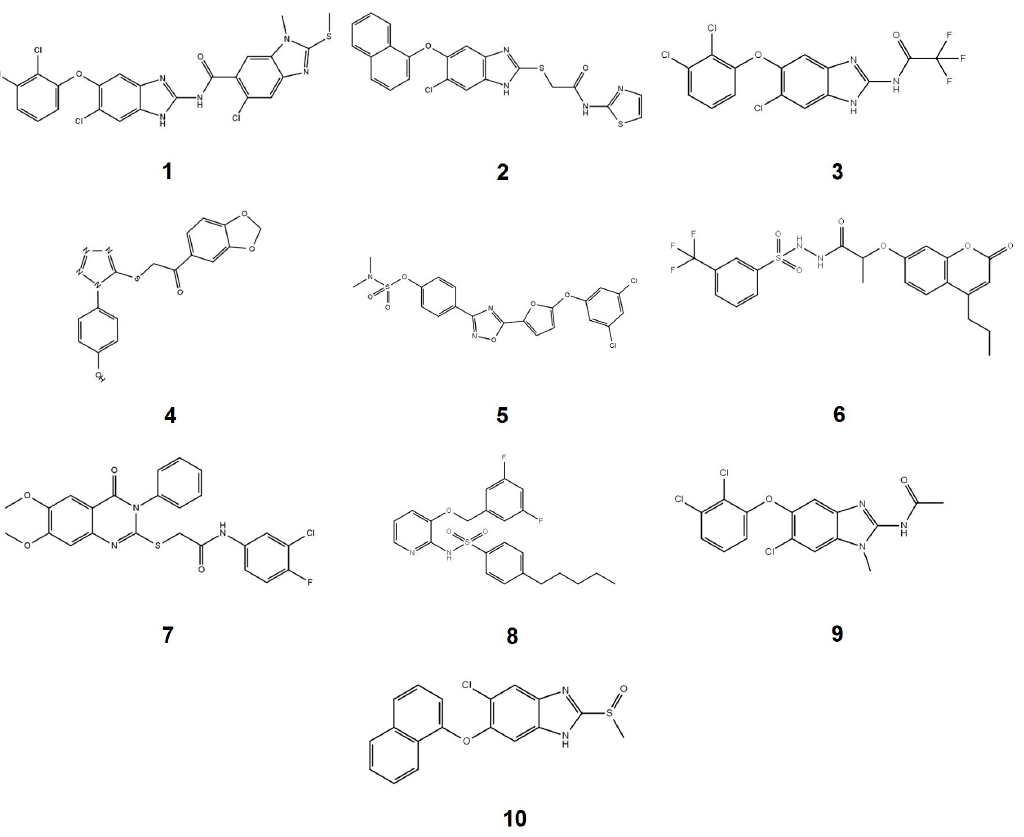
Figure 1. Chemical structures of the ten most potent PTP1B inhibitors. The number of each compound corresponds to that indicated in Table 1. corresponds to that indicated in Table